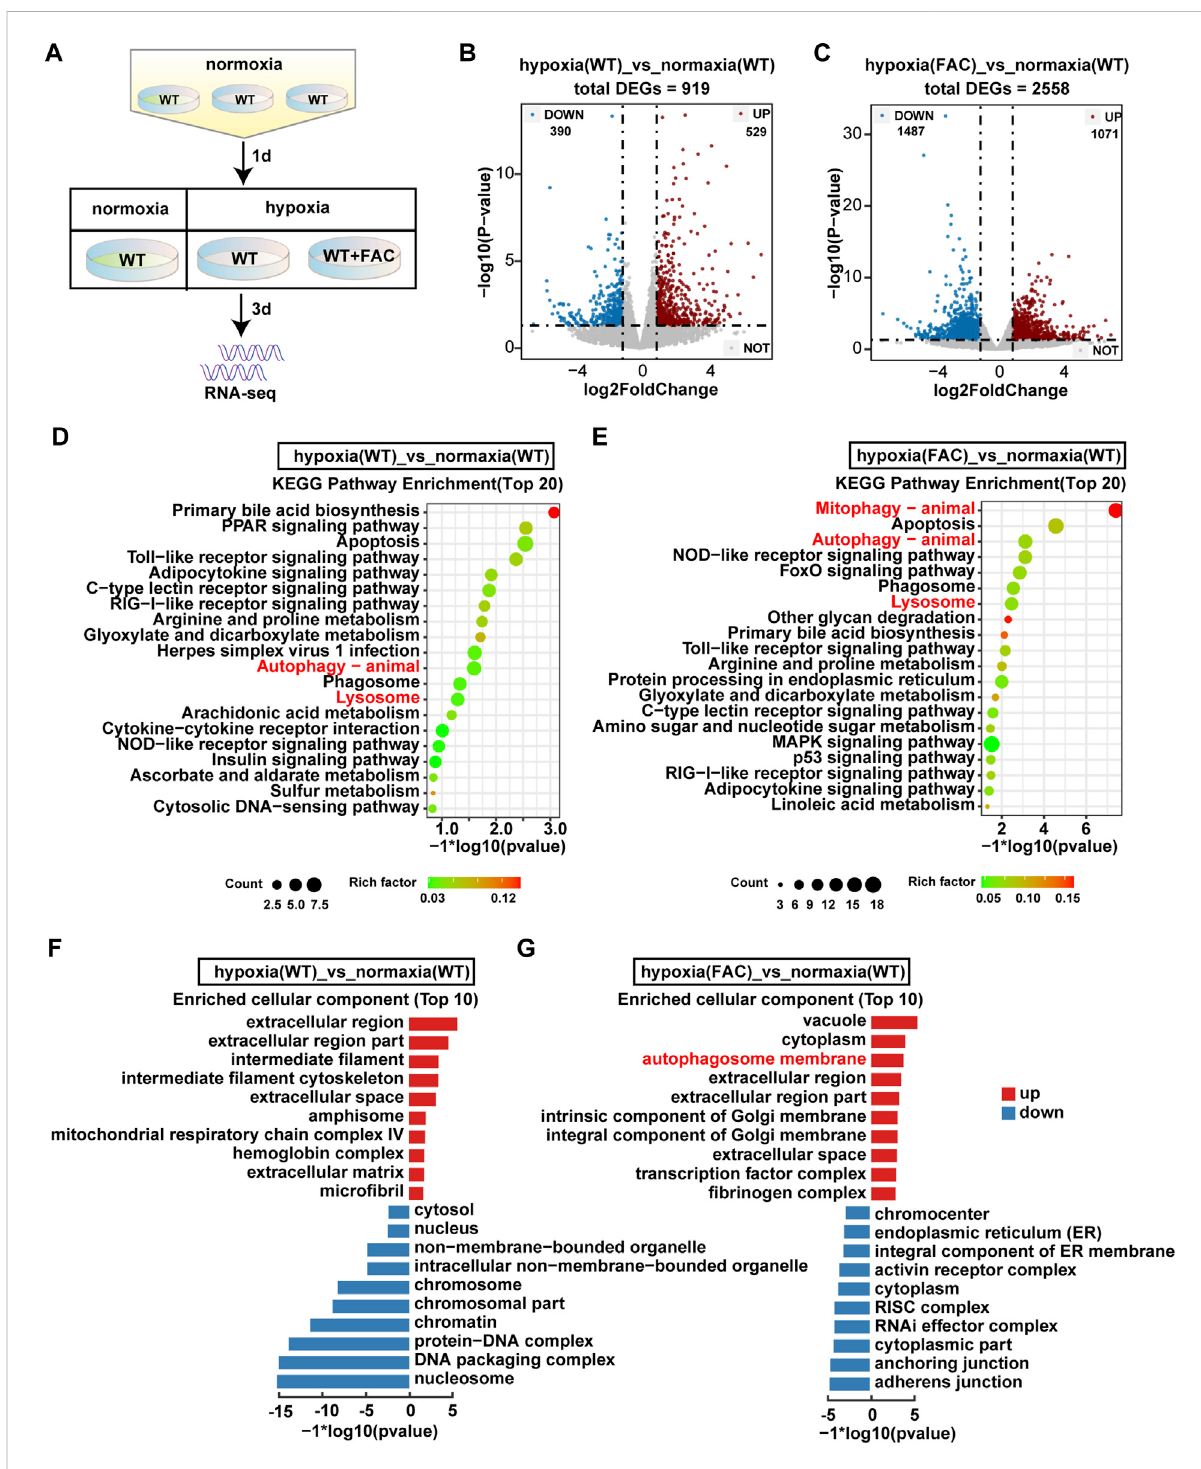
FIGURE 4 RNA-seqanalysisrevealedsigni fi canttransecriptomicchangesinhypoxiaZFLcell. (A) FlowchartofsamplprocessingforRNA-seq.WT:ZFLcell. WT+FAC:ZFLcelltreatedwithFAC. (B,C) Volcanicmapanalysisofgeneexpression.UP:up-regulateddifferentiallyexpressedgene;DOWN:down- regulated differentially expressed gene; NOT: non-differentially expressed gene. (D,E) The enriched KEGG pathways identi fi ed from up-regulated DEGsofhypoxia(WT) cell andhypoxia (FAC)cell compared withnormoxia(WT) cell. (F,G) GOenrichmenttestontheDEGsofhypoxia(WT) cell and hypoxia (FAC) cell compared with normoxia (WT)